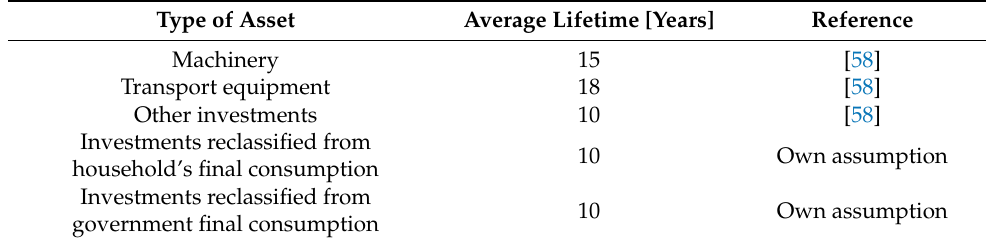
Table 2. Average life for each type of asset invested in the extended energy sector ([58] and own